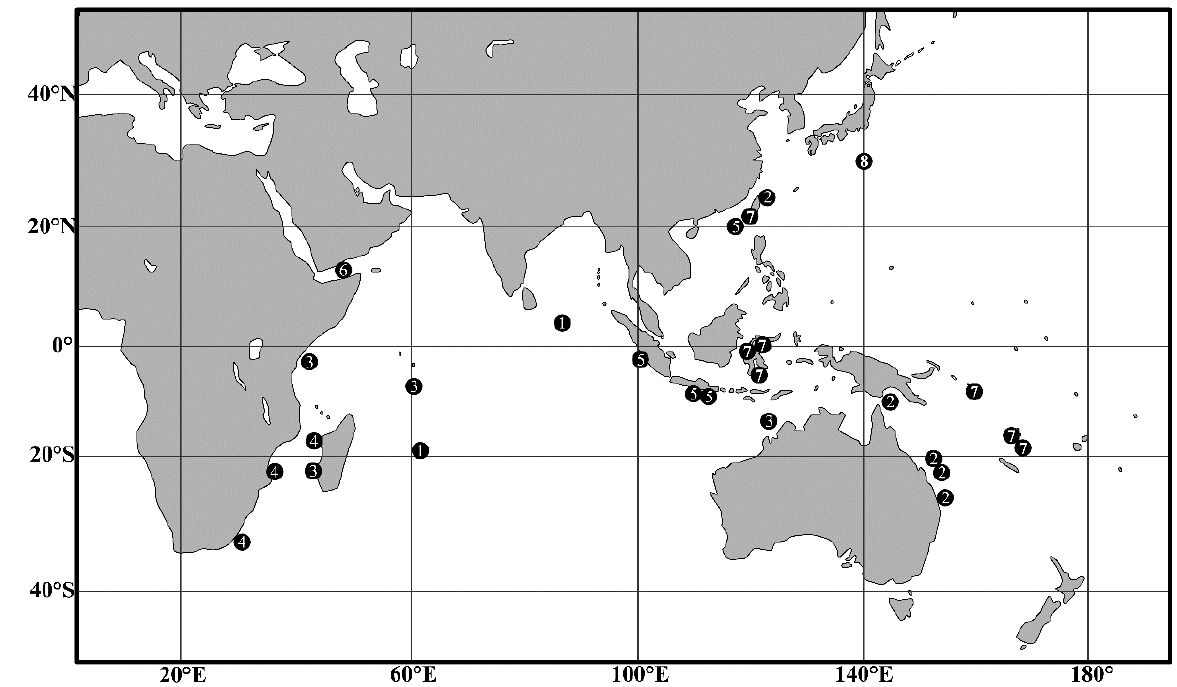
Figure 3. Distribution map of eight Halieutopsis species. 1. H. andriashevi ; 2. H. echinoderma sp. nov.; 3. H. galatea ; 4. H. ingerorum ; 5. H. kawaii sp. nov.; 6. H. murrayi sp. nov.; 7. H. oblonga ; 8. H. okamurai sp. nov. One dot may represent more than one